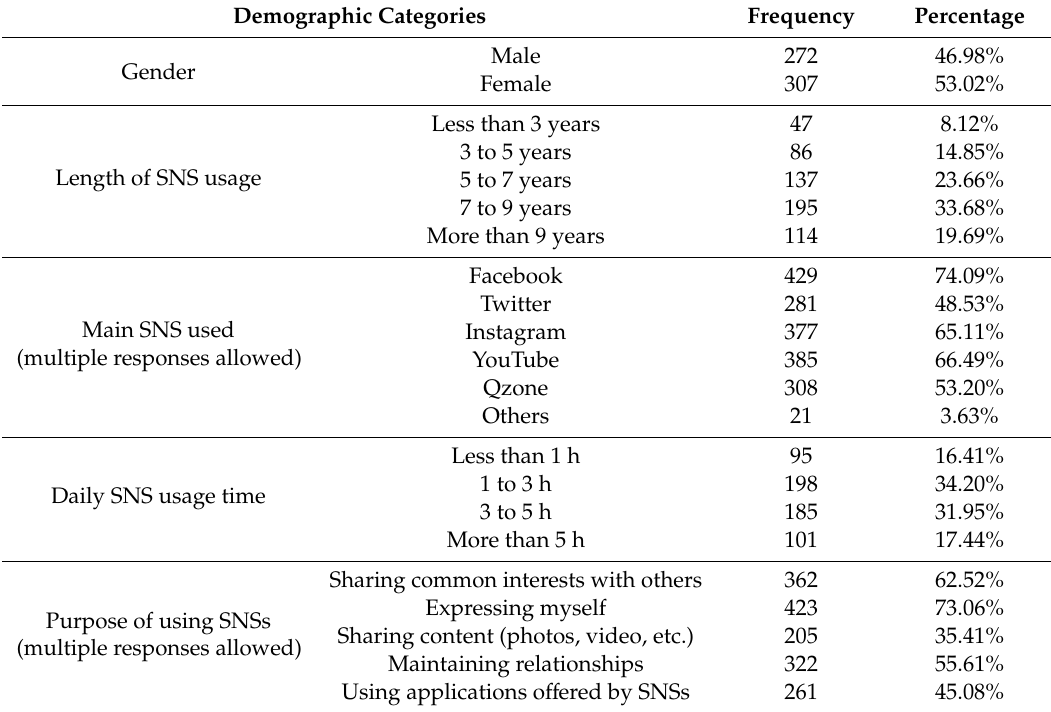
Table 2. Profiles of participants (n =